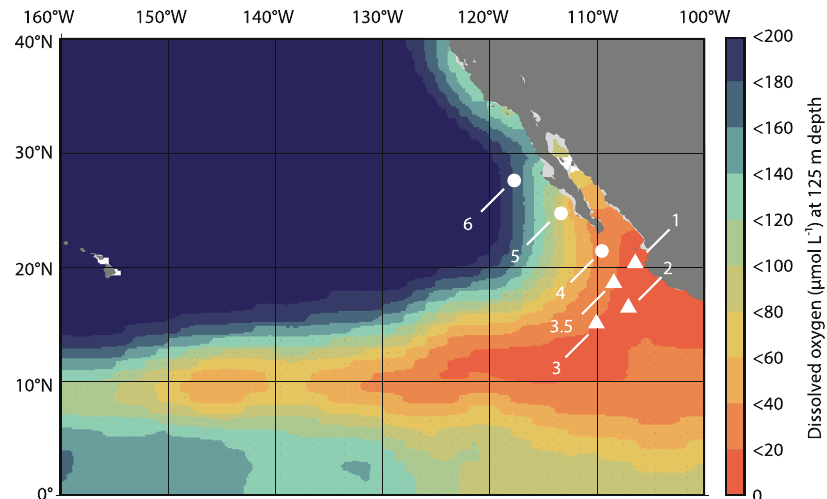
Fig. 1 Sampling locations. Sampling stations (numbered symbols) are plotted on dissolved oxygen concentrations (in µ M) at 125 m depth from the World Ocean Atlas. Triangles denote anoxic marine zone (AMZ) Stations 1 – 3.5 and circles denote oxygen minimum zone (OMZ) Stations 4 – 6. The color scale shows dissolved oxygen concentrations in 20 µ M